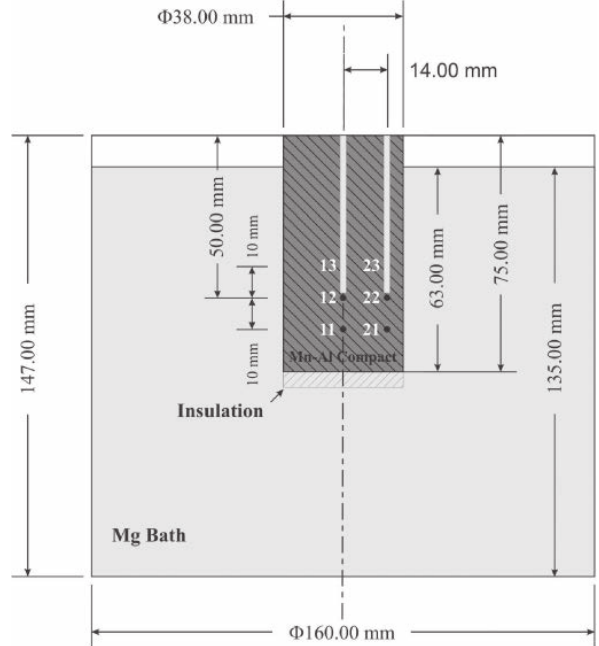
Fig. 7: Simulation configuration for a 3-D Mn-Al compact with thermocouple holes and bottom insulation immersed into a Mg bath